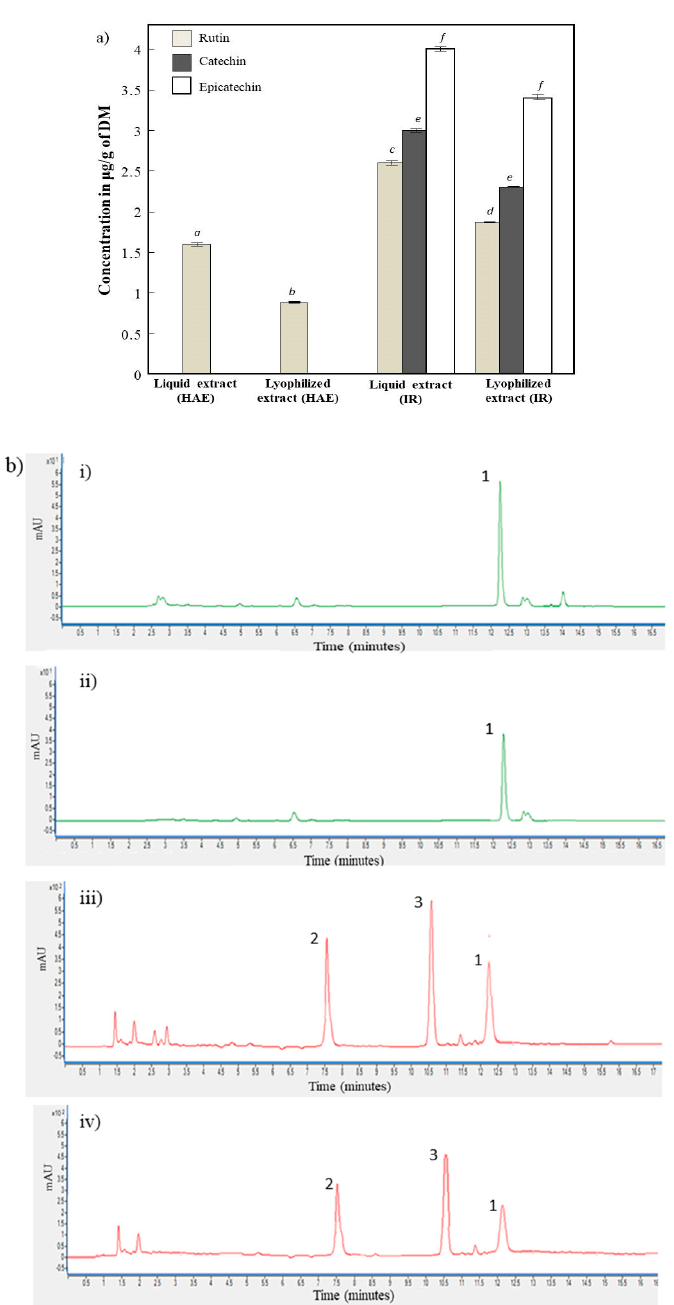
Figure 3. ( a ) Polyphenols composition of heat-assisted extraction and infrared apricot pomace extracts (liquid and lyophilized). Different superscript letters indicate significant statistical difference ( p < 0.05). (b) Chromatographic profile of the several phenolic compounds 1: Rutin, 2: catechin and 3: epicatechin of: i: liquid HAE, ii: lyophilized HAE, iii: liquid IR and iv: lyophilized IR.